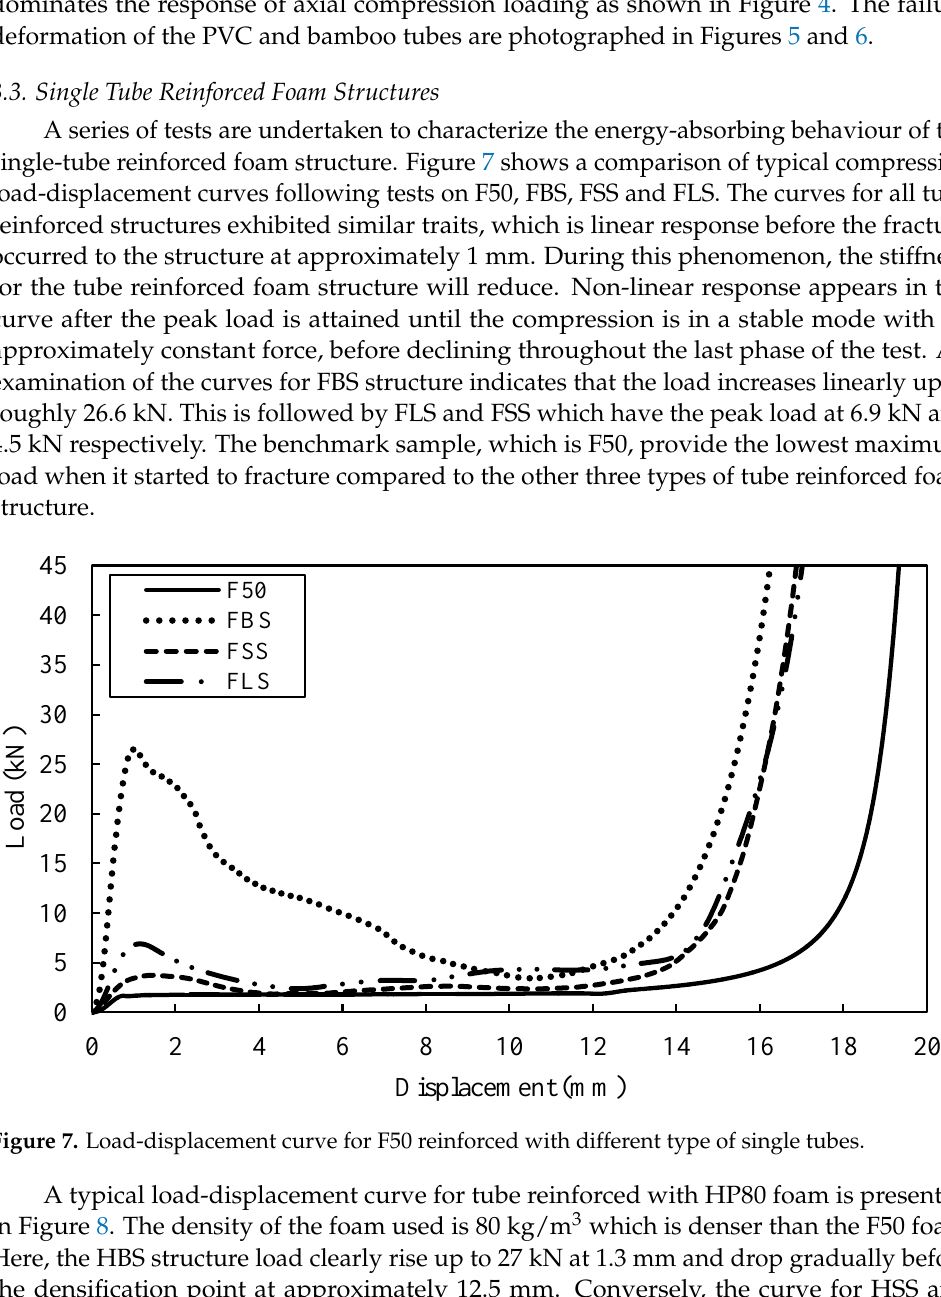
Figure 8. Load-displacement curve for HP80 reinforced with different type of single tubes. The deformation of the single tube reinforced foam structure after completing the compression process is shown in Figure 9. All the tubes were compacted and locked up at densification region when the tube walls have fully collapsed, as suggested by Rajput et al. [14]. Here, the lateral movement of tube reinforced structure is limited by increasing the foam density from 50 to 80 kg/m 3 . In Figure 9b, there is only a small amount of bamboo tube splitting is visible on the outside diameter. A closer look reveals that numerous of these fractures have penetrated to the neighbouring foam, similar to [15]. For PVC reinforced foam structures, the buckling and folding failure also being restricted with the increasing of foam density. Thus, the foam has been successful in constraining the lateral movement and failure mechanism.